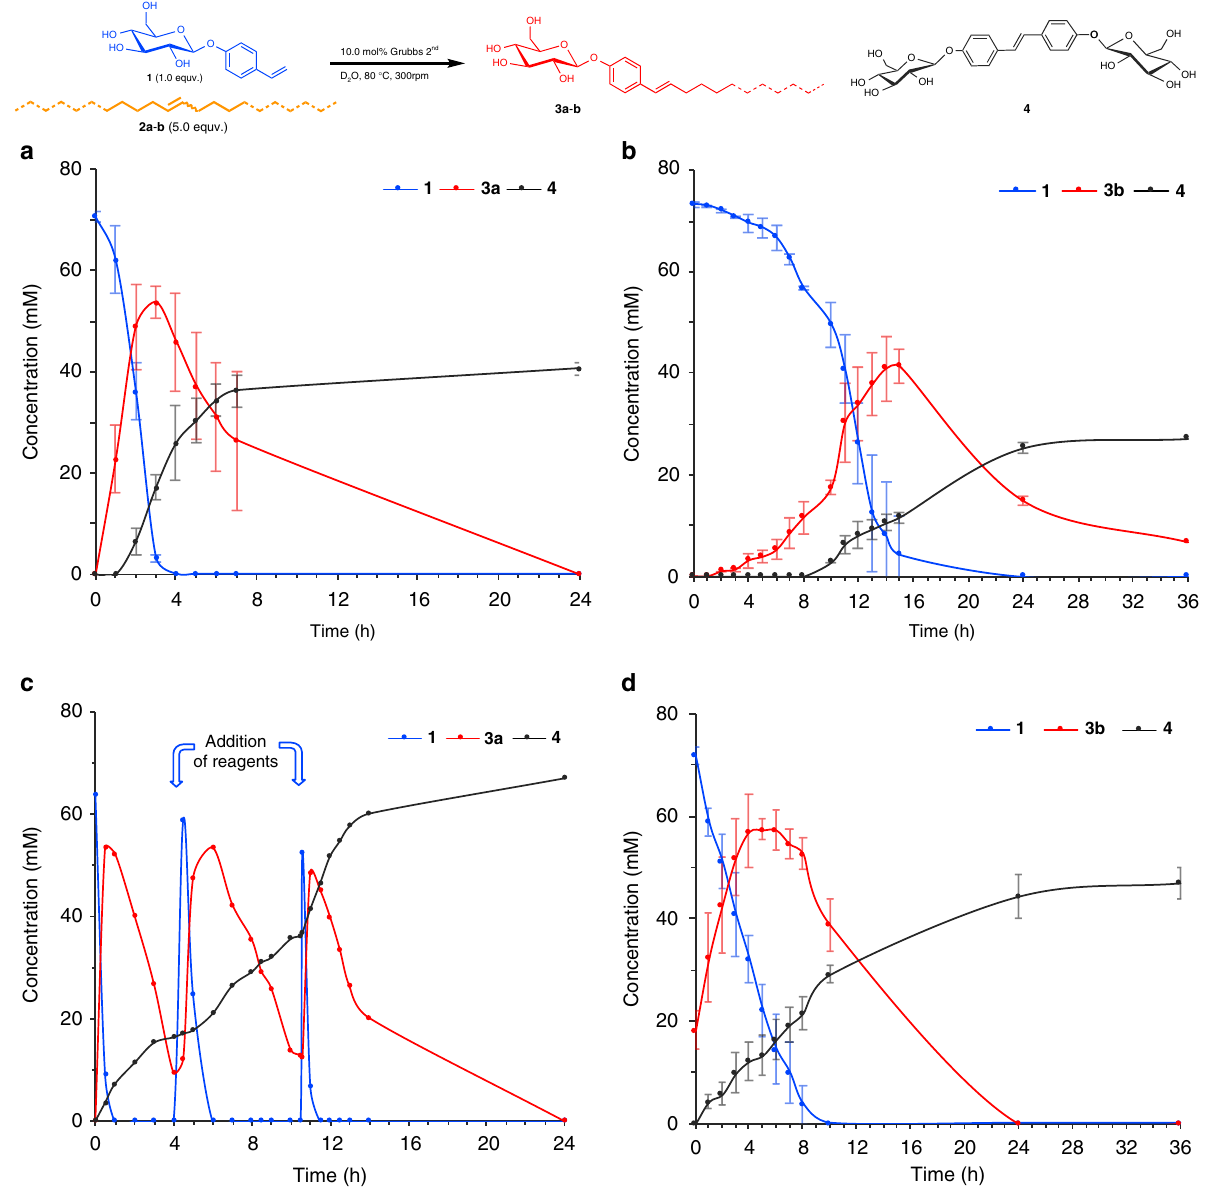
Fig. 2 Kinetics of the self-replicating system showing concentration versus time of 1 (blue), 3 (red) and 4 (black). a The reaction of hydrophobic alkene 2a with a shorter carbon chain, shows autocatalytic kinetics in the consumption of 1 and formation of 3a . After reaching a maximum, thermodynamically unstable product 3a is consumed to form waste product 4 . b The reaction of hydrophobic alkene 2b with a longer carbon chain again shows autocatalytic kinetics with a longer lag-period on account of the reduced water miscibility of alkene 2b . The peak in the concentration of 3b is again followed by its consumption to form waste product 4 . c Re-fuelling starting materials 1 and 2a , once 3a is depleted, allows for the self-replication to resume. An increased stirring rate is used to increase the rate of the reaction between 1 and 2a , but the same pattern observed in Fig. 2a emerges. d Reaction of hydrophobic alkene 2b , seeding with 20 mol% of surfactant 3b . In this case waste product 4 is formed from the beginning as the metastable replictator is already present. Error bars represent standard deviation obtained from three